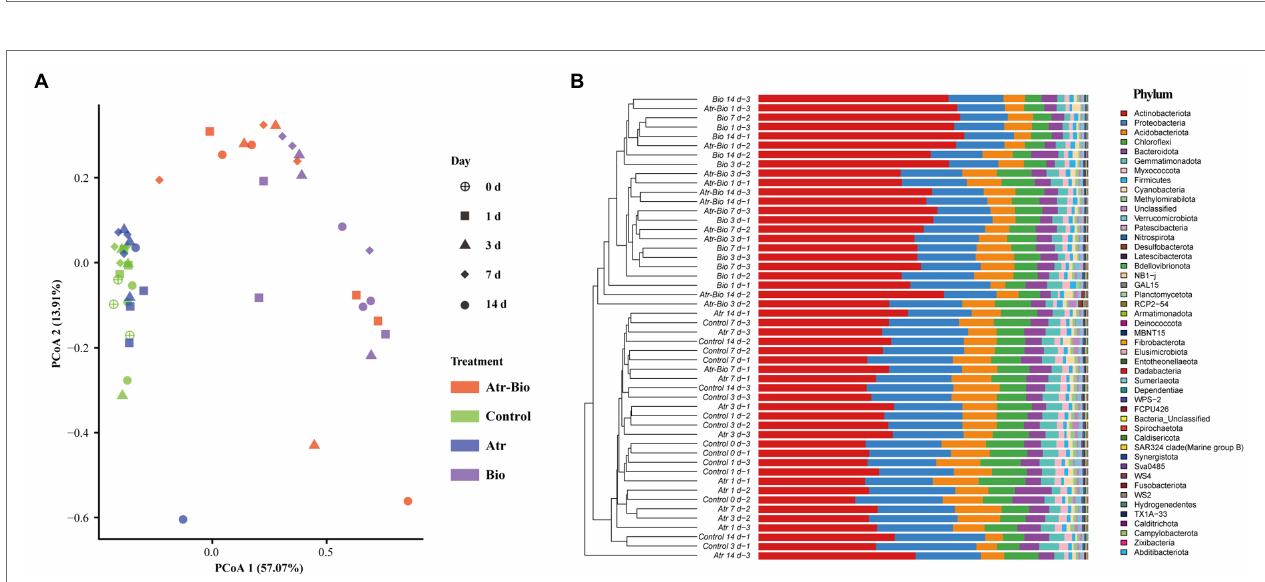
FIGURE 3 | Richness estimators and diversity indices of bacterial communities. (A) relative abundance of strain AT-5; (B) observed OTU numbers; (C) Chao1 indices; (D) Shannon indices; (E) Simpson indices (1-lambda). Control: equivalent amount of methanol and ddH 2 O were added into native soil; Atr: native soil spiked with atrazine; Atr-Bio: atrazine-spiked soil with inoculation of strain AT-5; Bio: native soil with inoculation of strain AT-5.